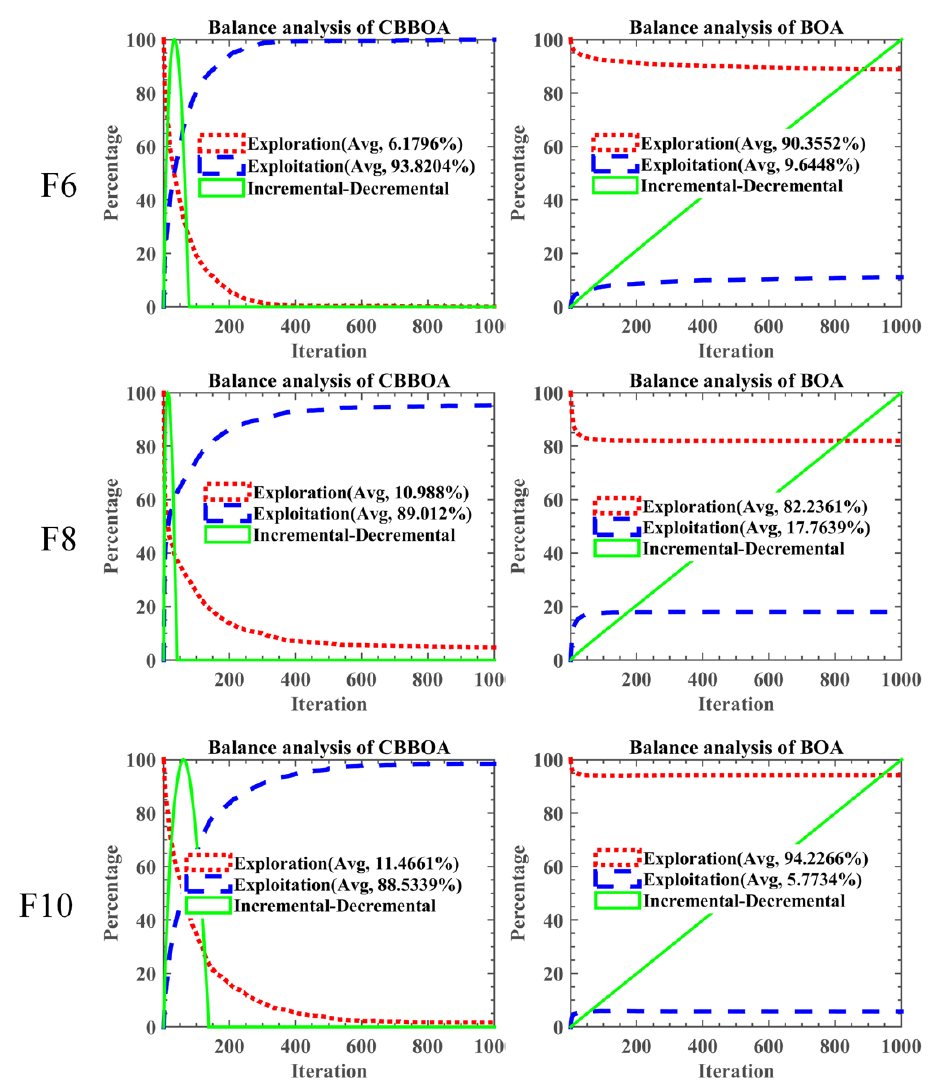
Figure 6. Balance analysis of CBBOA and BOA.